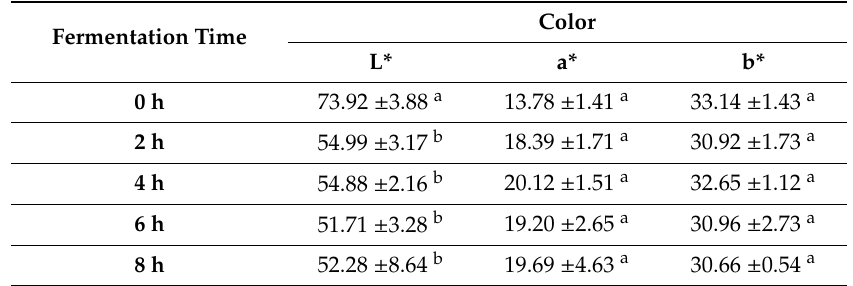
Table 2. Biscuit color analysis results from di ff erent fermentation times a, b di ff erent letters indicate significant di ff erences within the same column ( p <